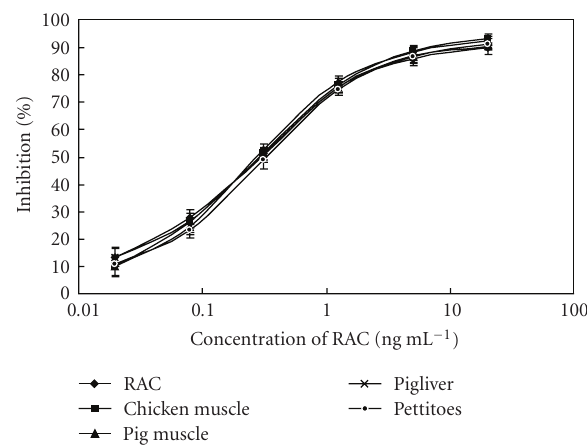
Figure 5: Standard curves of ractopamine in PBS bu ff er and in 4 sample extracts ( n =